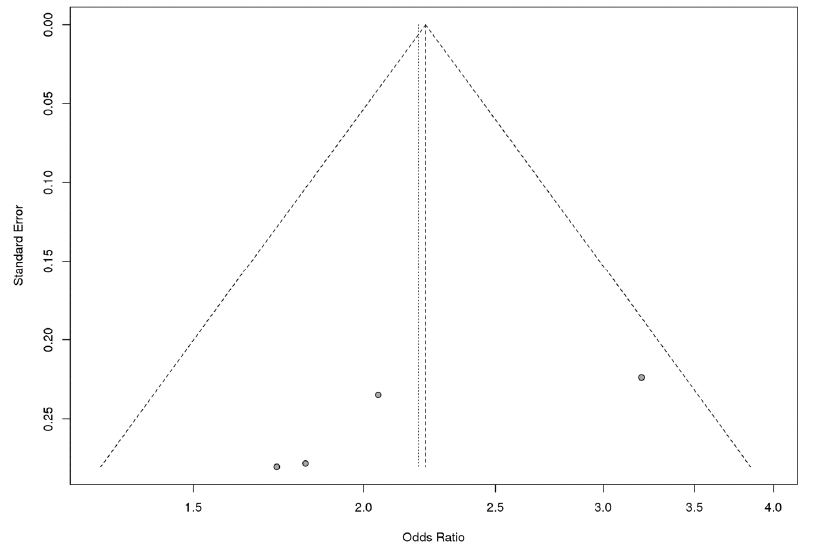
Figure 2. Begg’s funnel plot for the meta-analysis of the rs4986790 SNP of the TLR4 gene in four